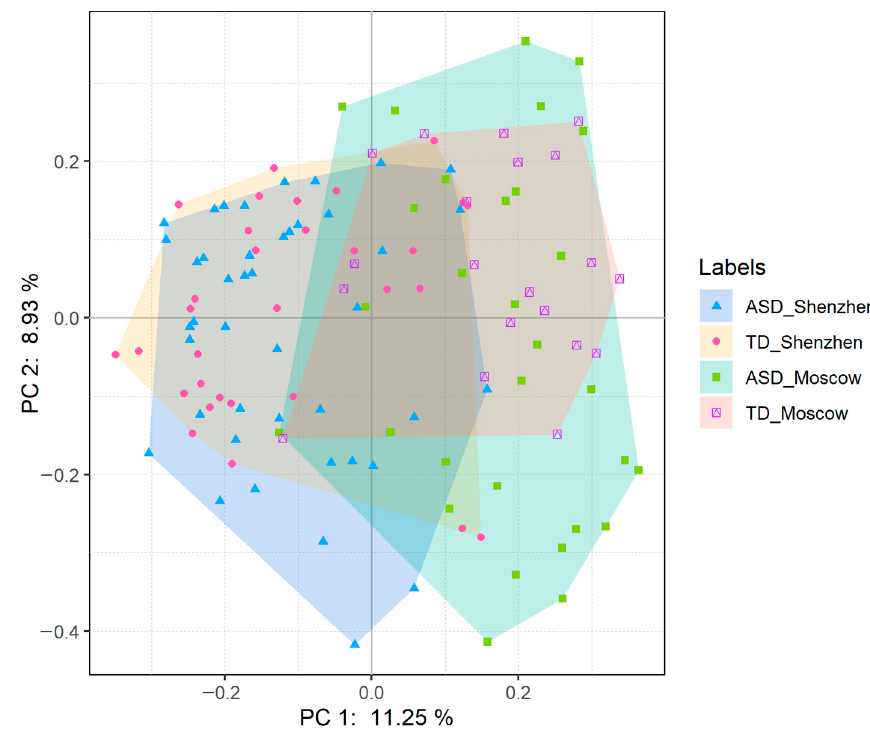
Figure 4. PCoA analysis based on Bray–Curtis algorithm. Results showed a clear clustering between two datasets and a similar tendency that the gut microbiota composition of the ASD group clusters was more heterogeneous than that of the TD